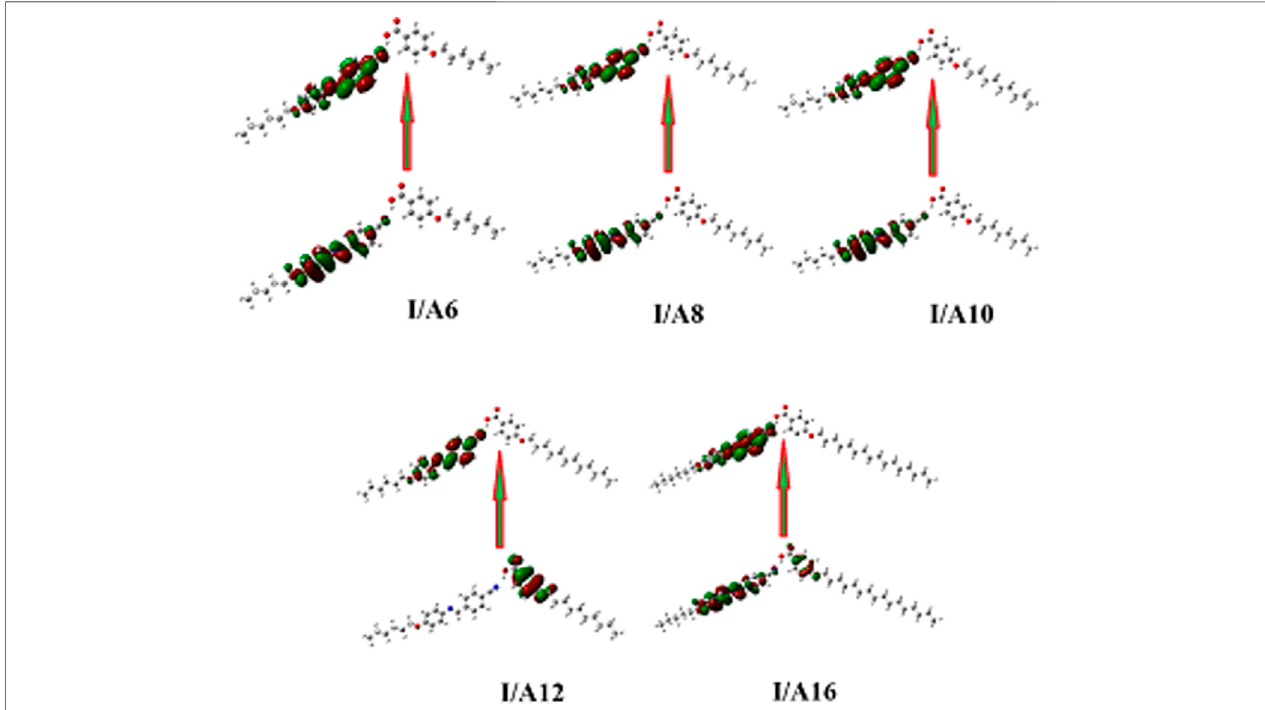
FIGURE 14 | The estimated plots for Frontier molecular orbitals of SMHBCs, I/An.